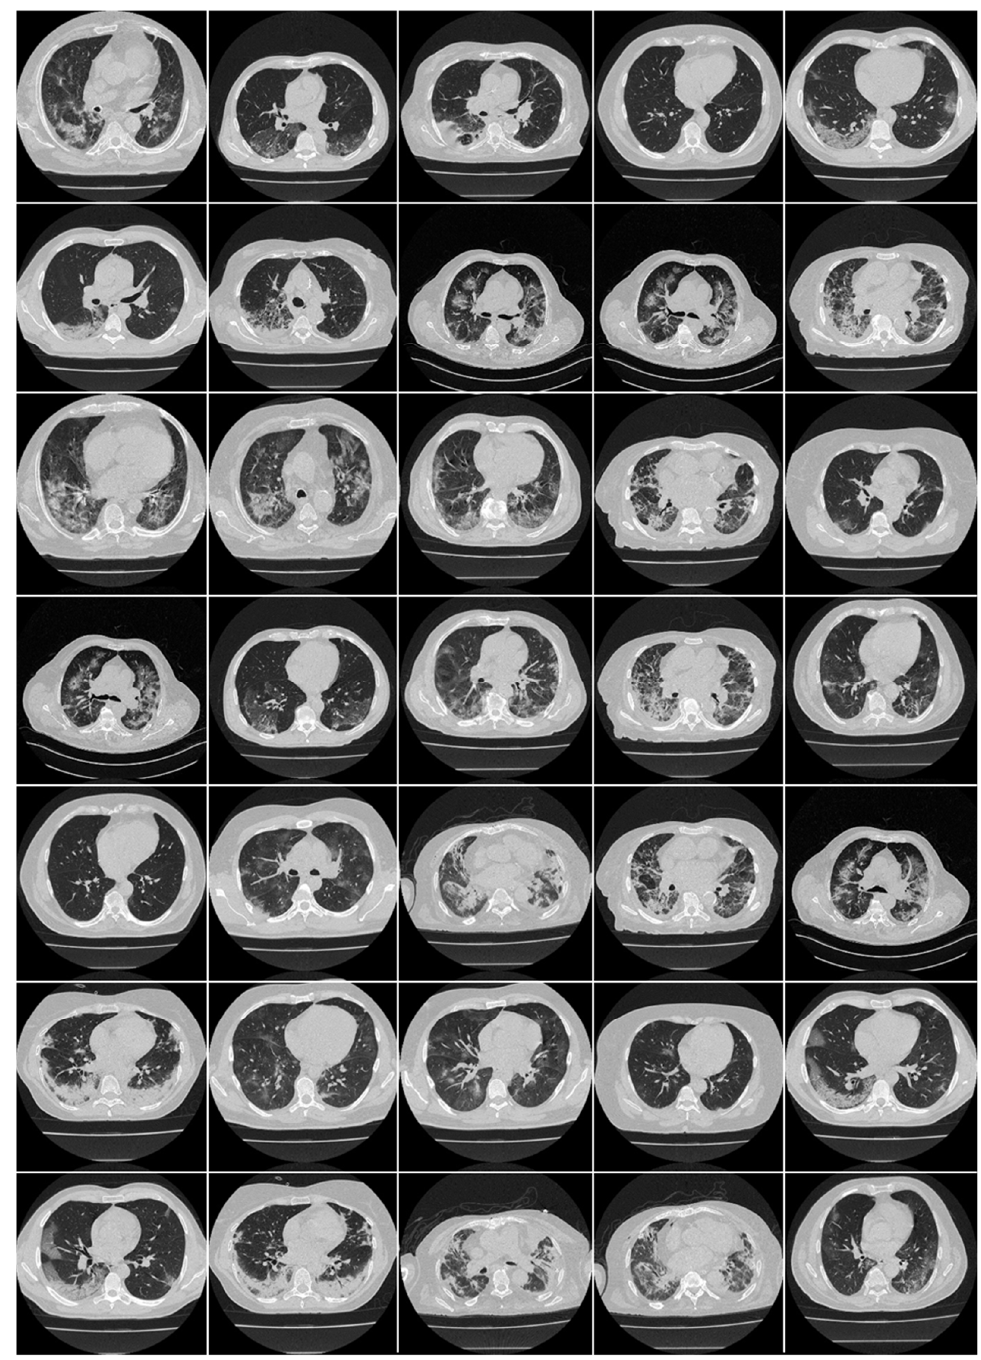
Figure 2. Raw CT slice of COVID-19 patients taken from Croatian data set.